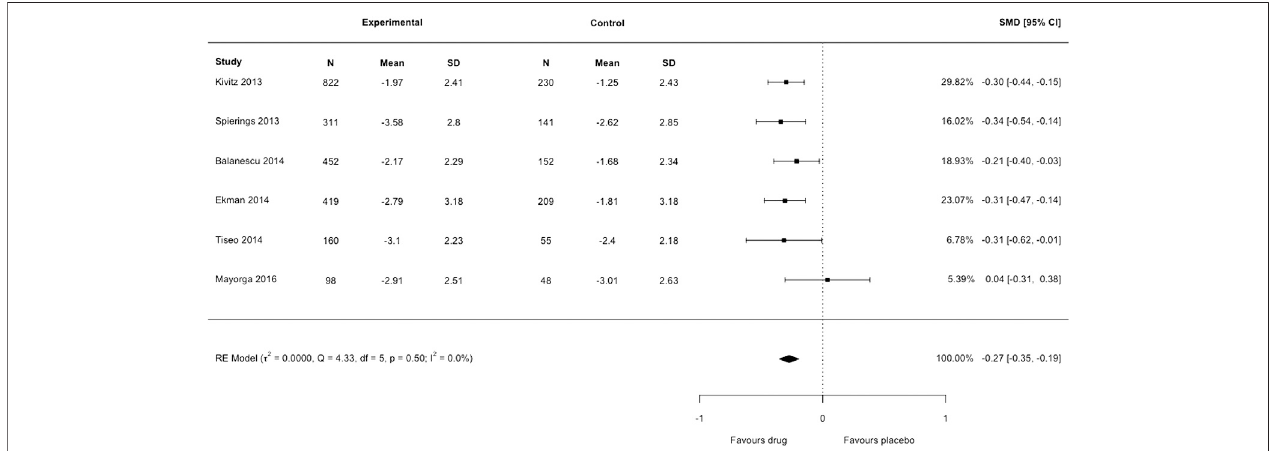
FIGURE 1 | Forest plot of changes from baseline to checkpoint for pain. This is a re-analysis in which we transformed the standard error reported in individual studies to standard deviation. SMD (cid:2) Standardised Mean Difference. CI (cid:2) con fi dence Interval. N (cid:2) number of participants.